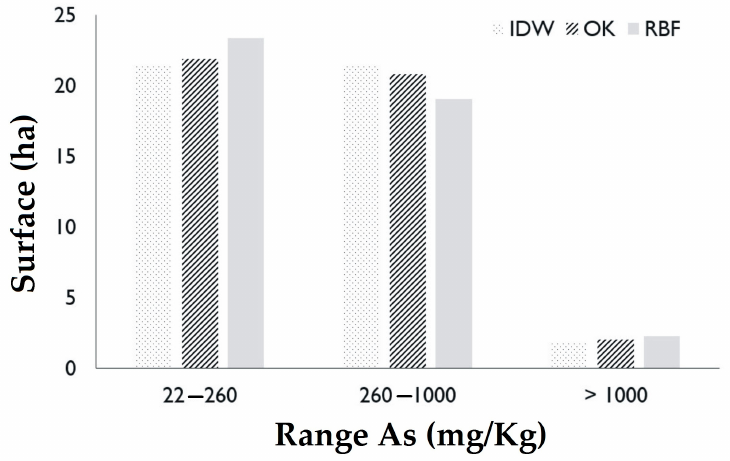
Figure 6. Surface by concentration range of As.